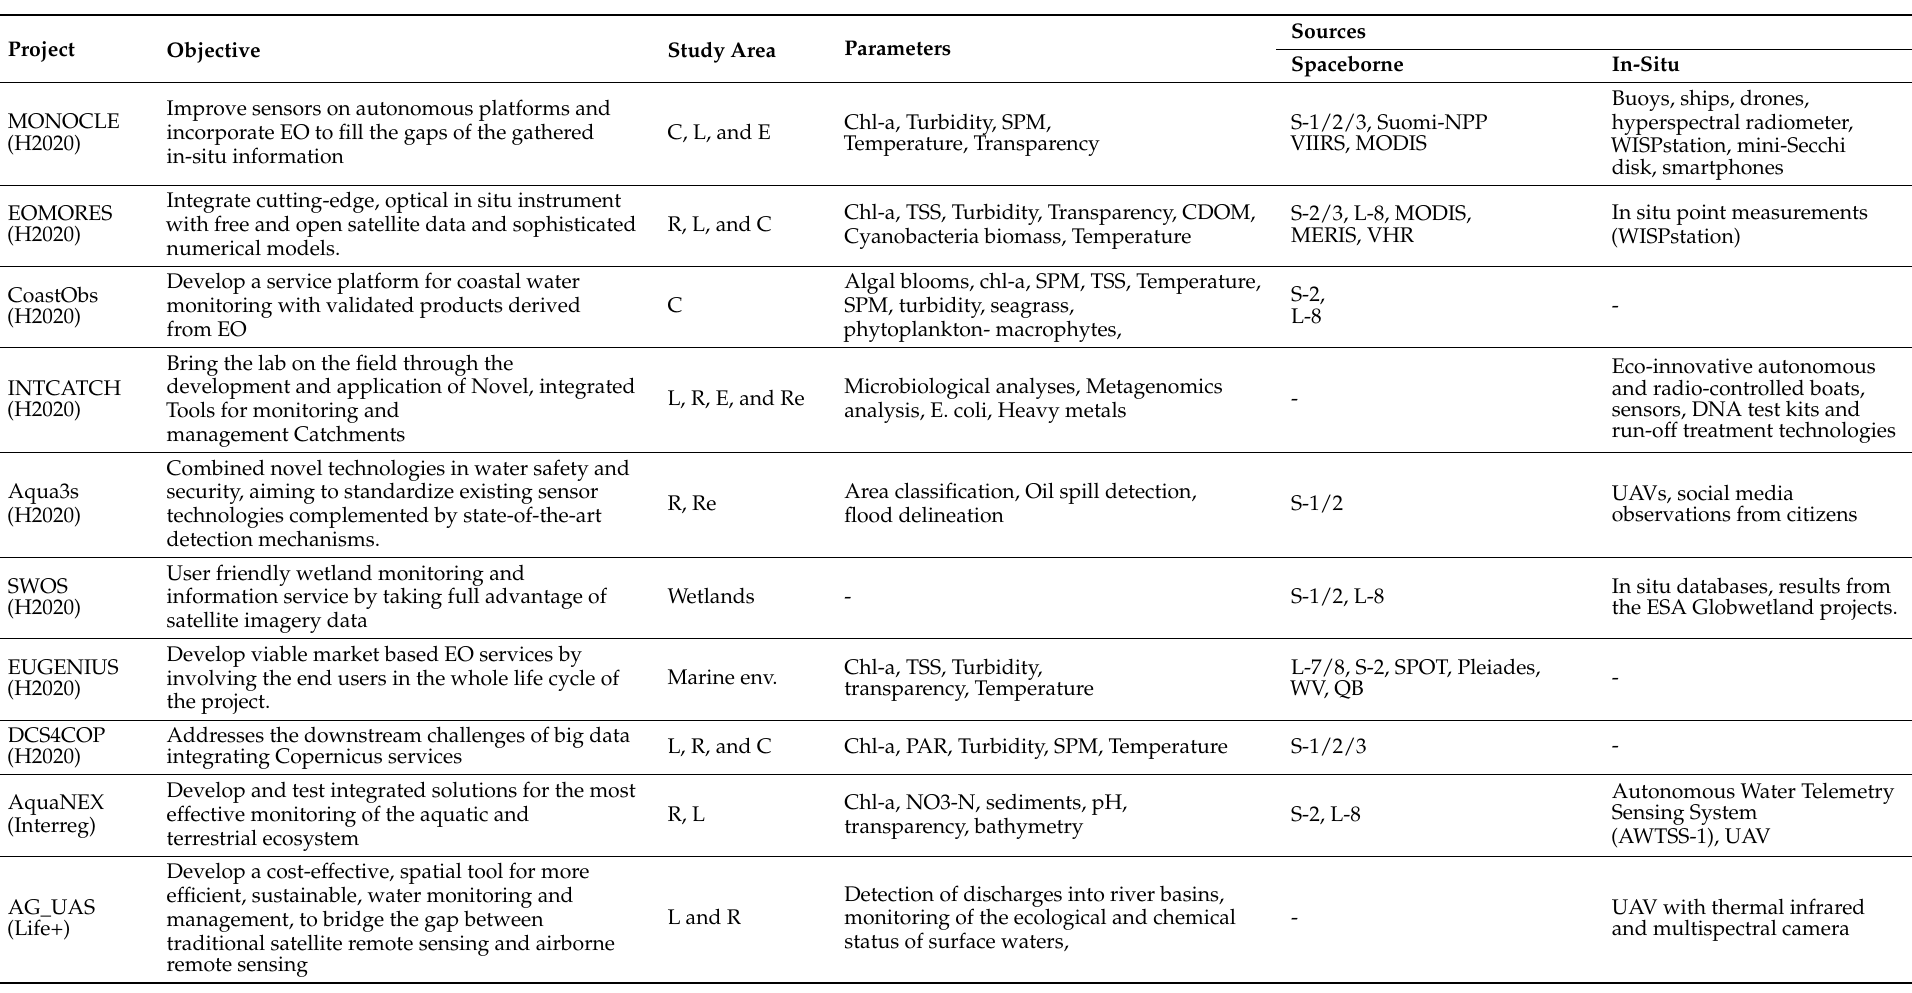
Table 5. Project overview analysis (for study area column: L = Lake, R = River, C = Coast, S = Sea, Re = Reservoir, La = Lagoon, E = Estuary; while for